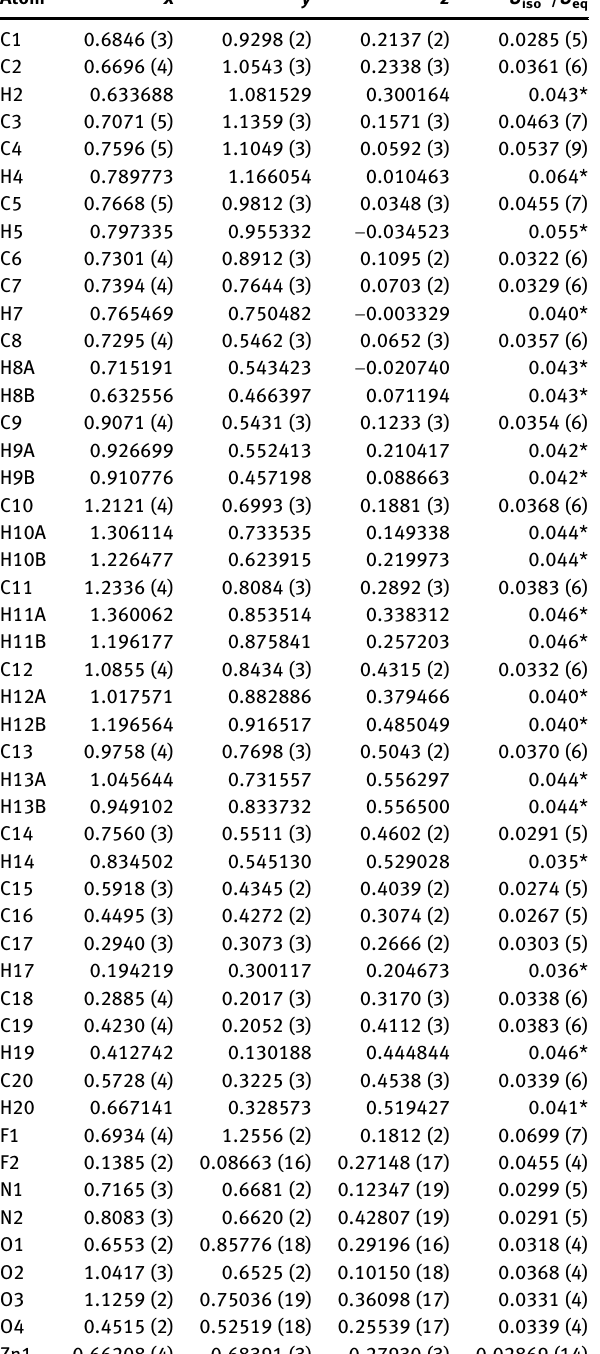
Table  : Fractional atomic coordinates and isotropic or equivalent isotropic displacement parameters (Å 